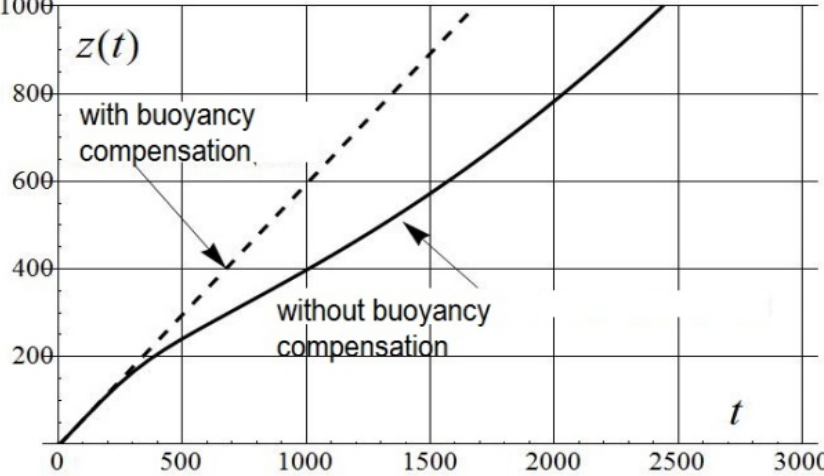
Figure 29. Submersion of the vehicle versus time for the buoyancy-compensated and non- compensated cases: equatorial waters, steel cylinder, l ∗ = l c = 2, η = 0.007.